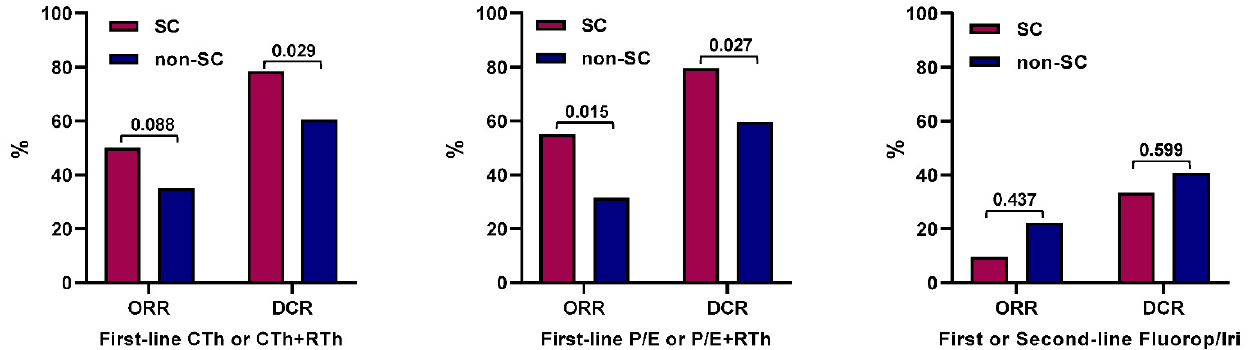
Figure 2. Response to treatment according to the morphological subtype. ORR, objective response rate; DCR, disease control rate; CTh, chemotherapy; RTh, radiotherapy; P/E, platinum/etoposide; Fluorop/Iri, fluoropyrimidine/irinotecan. P -values determined by Pearson’s chi-squared test or Fisher’s exact test are shown.